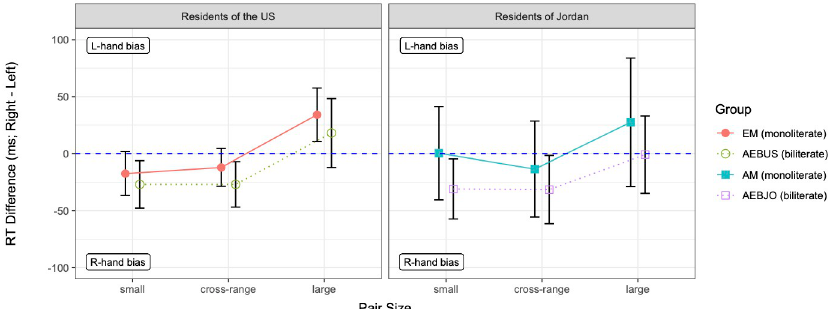
Fig 3. Mean RT differences (in milliseconds) in the larger condition, by group and pair size. Groups in the U.S. are plotted on the left; groups in Jordan on the right. Each pair size represents the average over the three pairs for that pair size. The dashed horizontal line marks zero RT difference (i.e., no hand bias); error bars mark 95% confidence